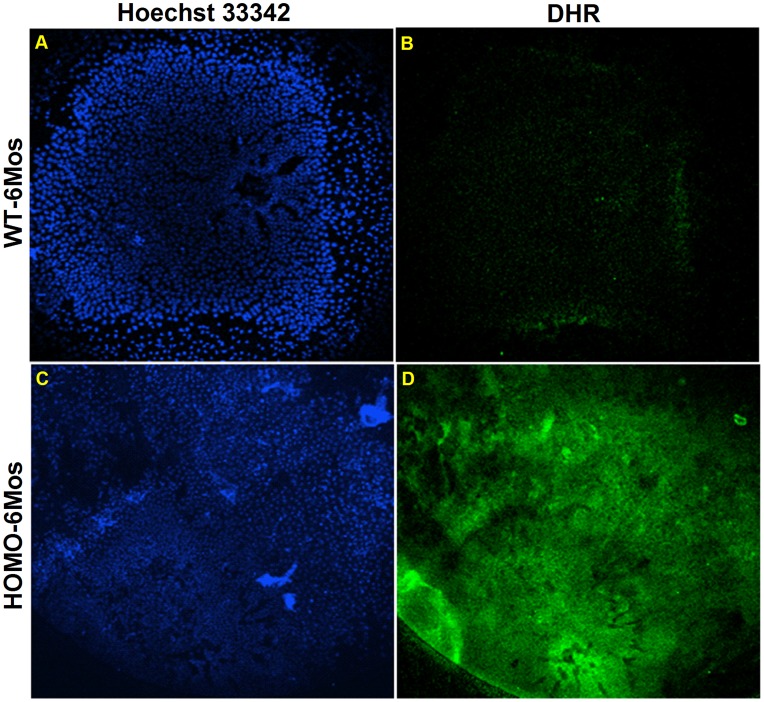
Comparison of lens anterior surfaces of 6 mos wild type and Homo-LEGSKO mouse lenses vitally stained for DNA and ROS.Fresh lenses were stained with both Hoechst 33342 and Dihydrorhodamine 123 (DHR). The Lens anterior was scanned using 10X objective, and 65 µm deep into the cortex and 0.8 µm layer Z-scan was performed and projection image was obtained with same method for both WT and LEGSKO lenses. (A) and (C). Comparison of DNA staining with Hoechst 33342 (blue) of the anterior surface of Wt and LEGSKO lenses. (B) and (D). Comparison of vital staining for ROS fluorescence with DHR stain (green) of the same surface areas.